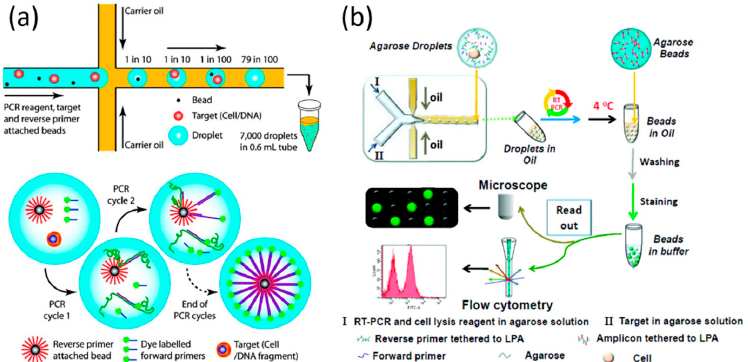
Figure 5. Microfluidic droplets enabling single-cell genomic analysis. ( a ) Individual cells together with primer-functionalized microbeads were encapsulated in uniform PCR mix droplets. After bulk PCR amplification, the droplets were lysed and the beads were recovered and rapidly analyzed via flow cytometry. Reproduction with permission from [71]; and ( b ) an agarose droplet-based microfluidic method for emulsification RT-PCR, where reverse primers were covalently conjugated to agarose, which functioned as the trapping matrix to replace conventional primer functionalized microbeads, resulting in high PCR efficiency (~95%). Reproduction with permission from [81]. Table 2. Key developments of microfluidic droplets enabling single-cell genomic analysis. Interested Gene Sections Working Mechanisms